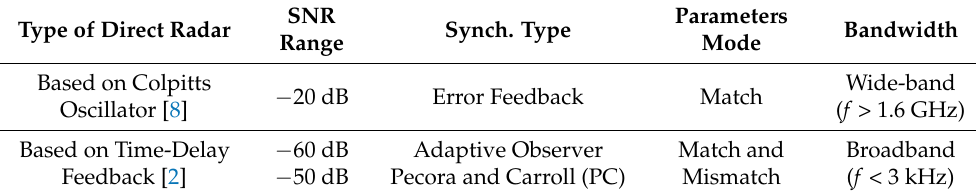
Table 1. A comparison example of the direct Chaotic Radars. Type of Direct Radar